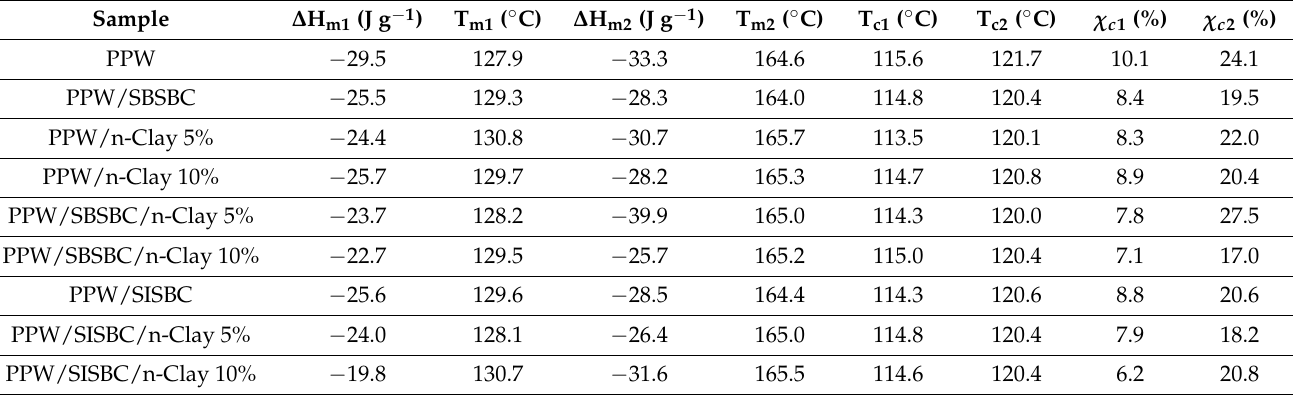
Table 4. Thermal data of PPW/SBSBC, PPW/SISBC, PPW/SBSBC/n-Clay, and PPW/SISBC/n-Clay samples obtained from the first heating and cooling process.